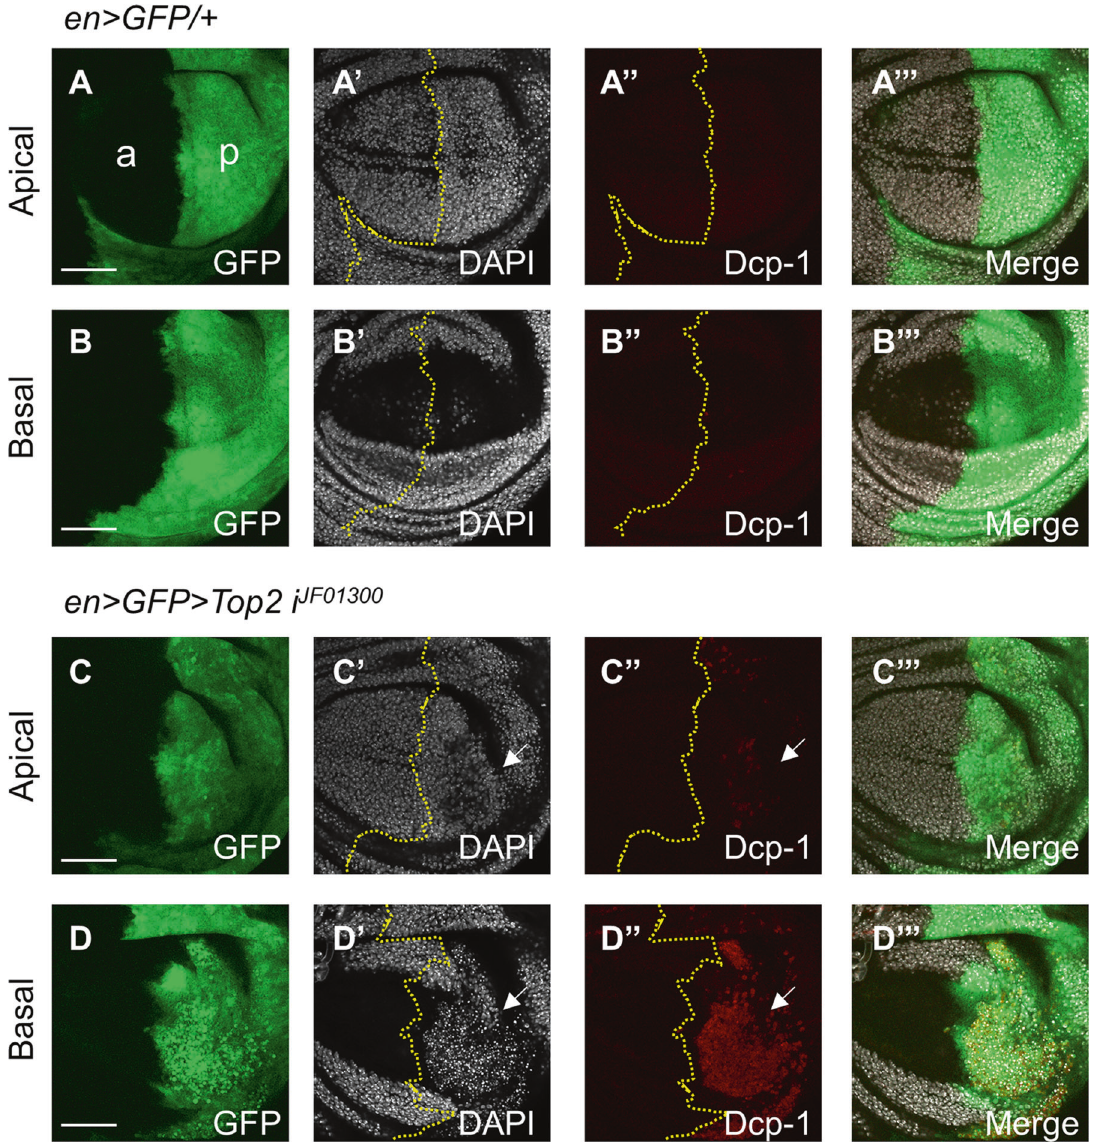
Fig. 2 Top2 RNAi increases cell death. A – B ’’’ en > GFP/ + shows no change in the DAPI and Dcp-1 staining in the posterior region at 29 °C. A – A ’’’ Apical section. B - B ’’’ Basal section. Staining for GFP, DAPI, and Dcp-1 is as indicated in each panel. Yellow dotted lines in ( A ’– D ’’ ) indicate the A/P boundary. Scale bars in ( A – D ) are 50 µm. a anterior, p posterior. C – D ’’’ en > GFP > Top2 RNAi JF01300 shows increased Dcp-1 staining in the posterior region at 29 °C (3/3 discs; 100%). C – C ’’’ Apical section. Dcp-1 staining is weakly increased (White arrow) ( C ” ). D – D ’’’ Basal section. Dcp- 1 staining is strongly increased (White arrow in D "). DAPI staining is decreased (White arrow) in the posterior apical region ( C ’ ) while it is accumulated (White arrow) in the posterior basal region ( D ’